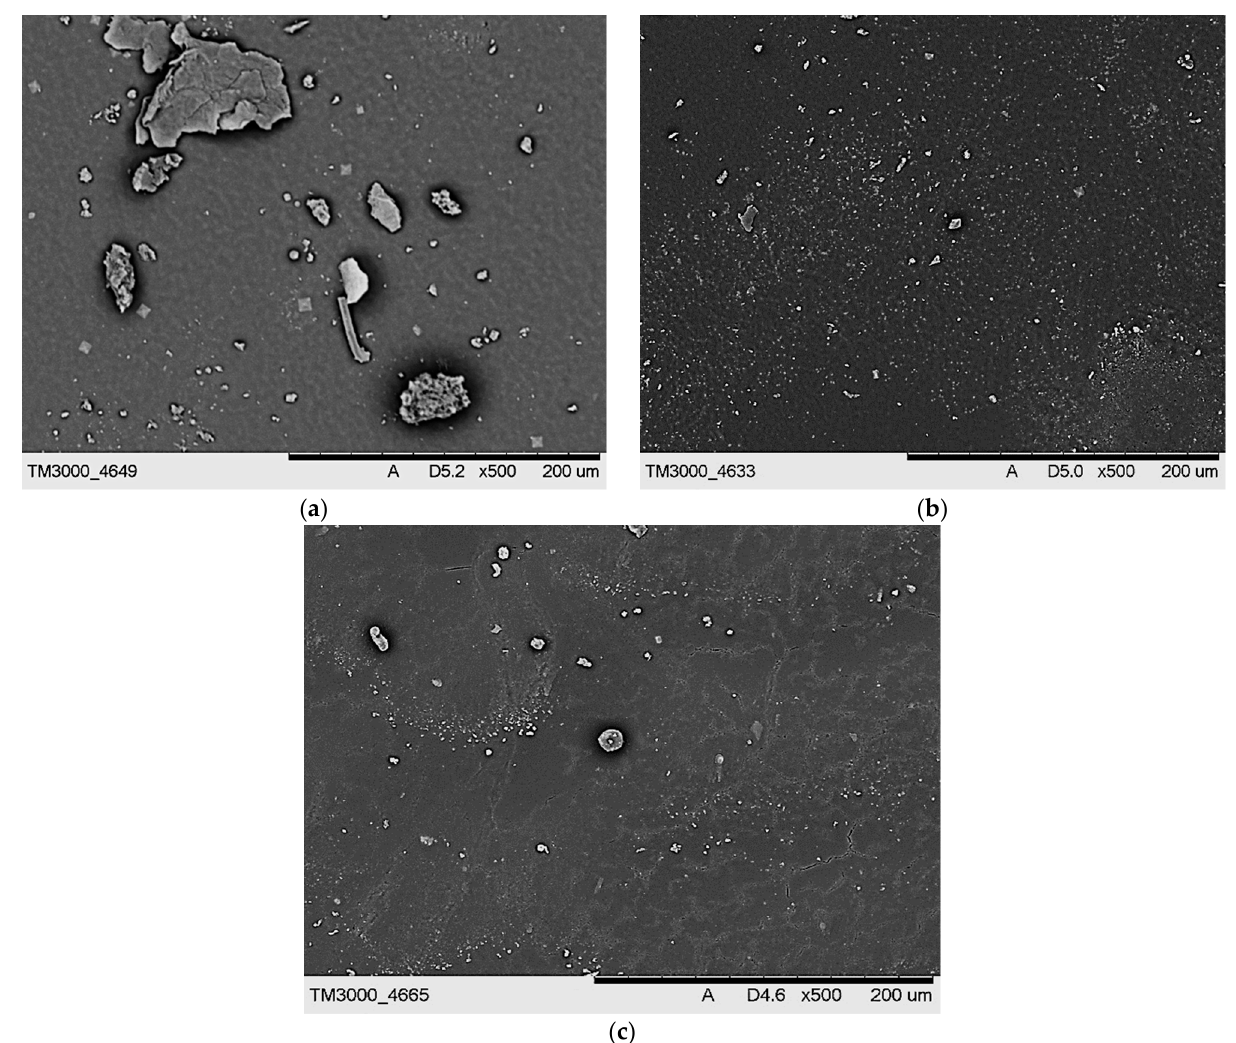
Figure 10. SEM images of hydrogel samples containing PEGDA 575: ( a ) 1.5 mL, ( b ) 2.0 mL, and ( c ) 2.5 mL.